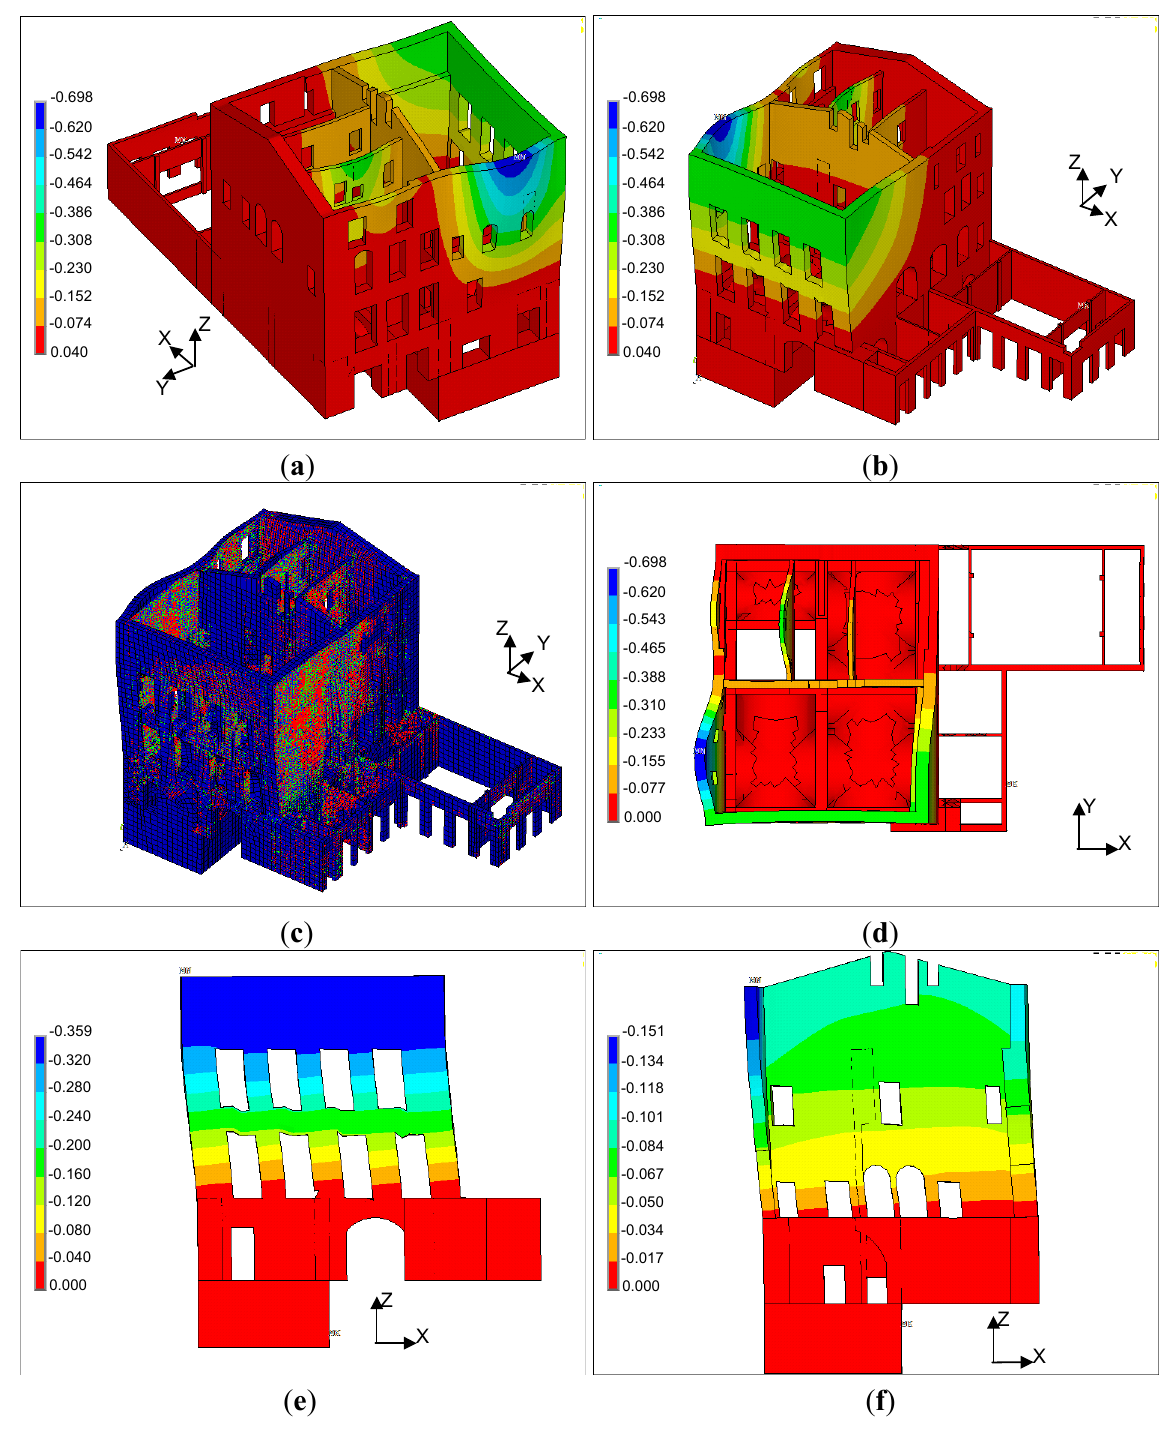
Figure 12. Pushover analysis results (–X direction): ( a ), ( b ), ( d ), ( e ) and ( f ) horizontal displacement in X direction (units are m), ( c ) final cracking and crushing